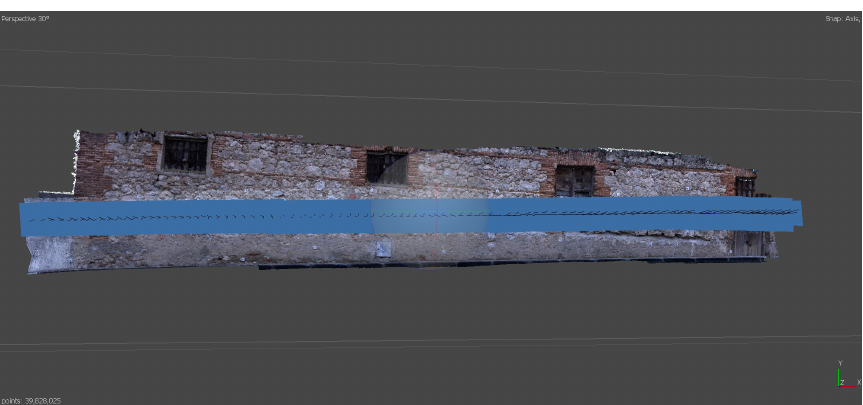
Figure 12. Distribution of the shots taken during visible spectrum capture process (front view). Five different point clouds were obtained as a final output of this data processing phase, corresponding to different spectral bands: red, green, blue, infrared and ultraviolet. To clarify, the geometry of the visible spectral point cloud, as all the points positions coincide because they come from the same cloud, has been split into three different